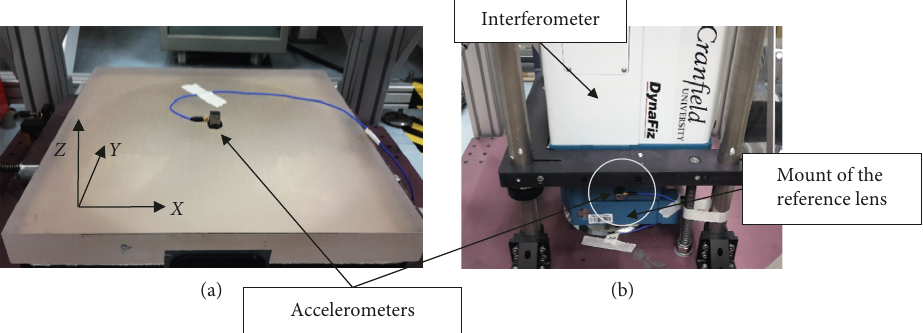
Figure 12: (a) The accelerometer on the test piece centre. (b) The accelerometer secured onto the mount of the reference